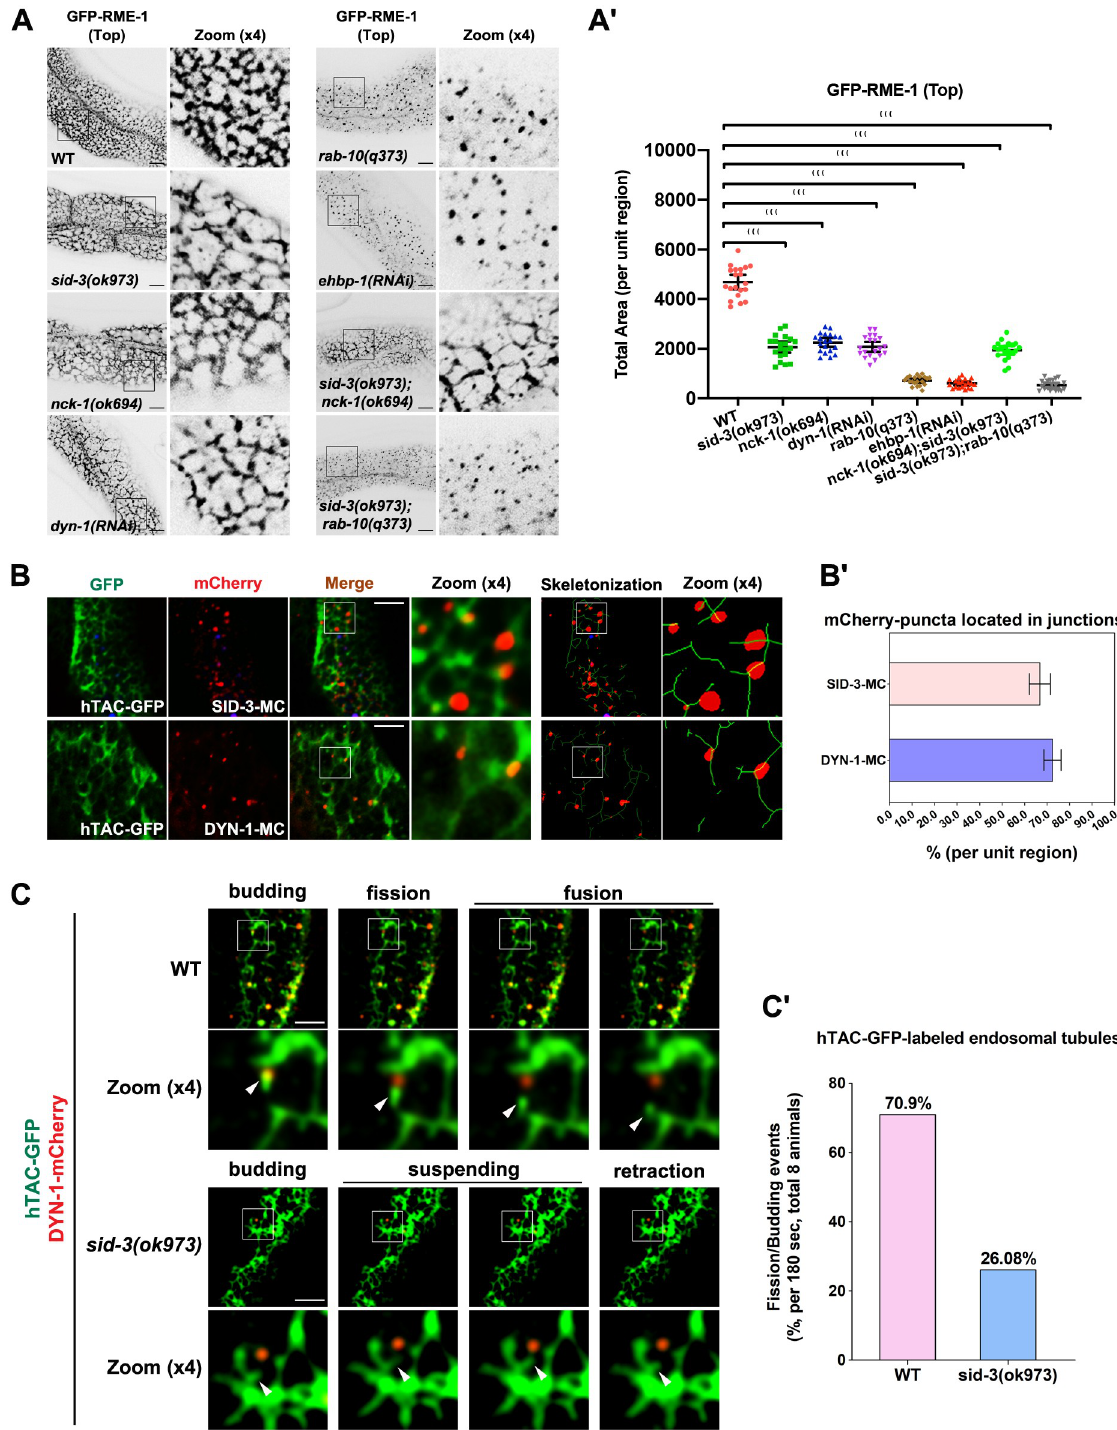
Fig 5. SID-3 is required for endosomal tubules fission. ( A-A’ ) Confocal images showing GFP-RME-1-labeled endosomes in the intestinal cells. GFP-RME-1-labeled basolateral (Top) recycling endosomes were reduced in sid-3(ok973) , nck-1(ok694) , sid-3(ok973) ; nck-1(ok694) , and dyn-1(RNAi) (P0 adults were scored) cells. GFP-RME-1-positive endosomal meshwork collapsed in rab-10(q373) , ehbp-1(RNAi) , and sid-3 (ok973) ; rab-10(q373) cells. Error bars are 95% CIs (n = 20 each, 10 animals of each genotype were sampled in whole-cell regions of two intestinal cells). Asterisks indicate the significant differences in the Mann-Whitney test ( ��� p < 0.001). ( B-B’ ) Confocal images showing the colocalization between hTAC-GFP and SID-3-mCherry or DYN-1-mCherry in the intestines. SID-3 and DYN-1 are located in the